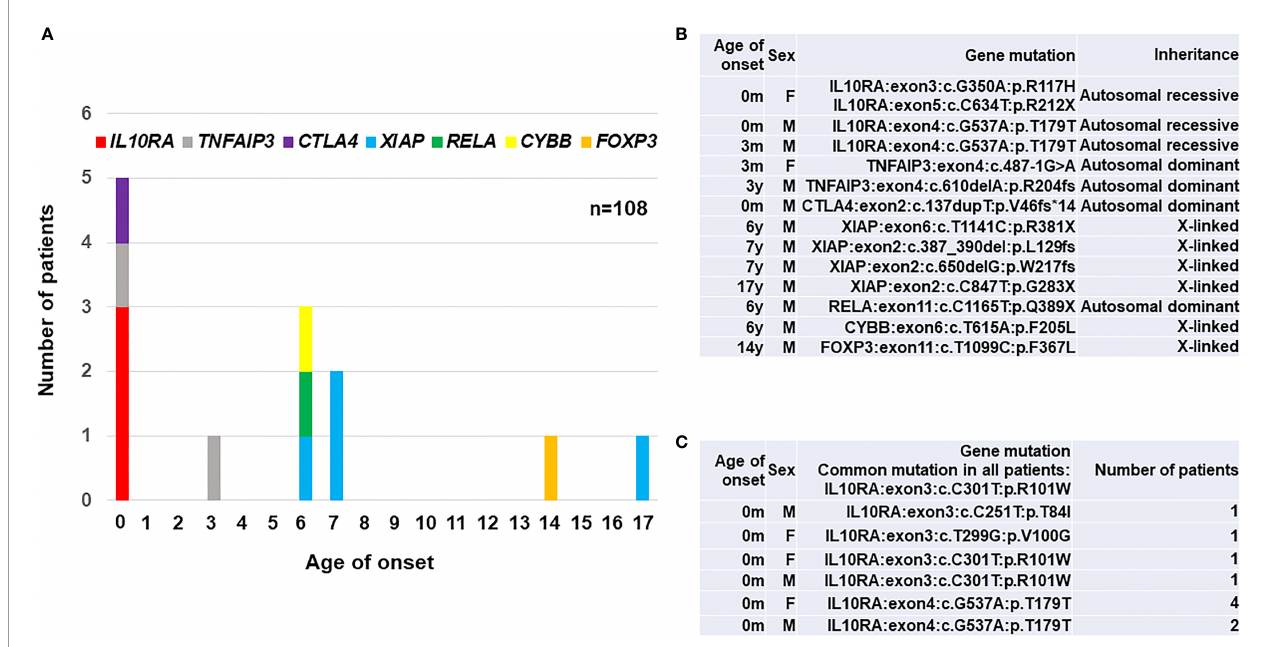
FIGURE 1 | A summary of 23 patients with PID-associated early-onset IBD in East Asia. (A) Age distribution of disease onset according to the responsible genes in 13 Japanese patients. (B) A list of disease-causing mutations in responsible genes for PID in 13 Japanese patients (17, 18). (C) A list of disease-causing mutations in 10 patients with IL-10RA de fi ciency reported from Hong Kong (19) and China (20). A synonymous p.T179T variant caused a splicing error in IL10RA gene. IL10RA, interleukin-10 receptor subunit alpha; TNFAIP3, tumor necrosis factor alpha-induced protein 3; CTLA4, cytotoxic T-lymphocyte-associated protein 4; XIAP, X-linked inhibitor of apoptosis protein; RELA, v-rel avian reticuloendotheliosis viral oncogene homolog A; CYBB, cytochrome b beta; FOXP3, forkhead boxprotein P3; M, male; F,